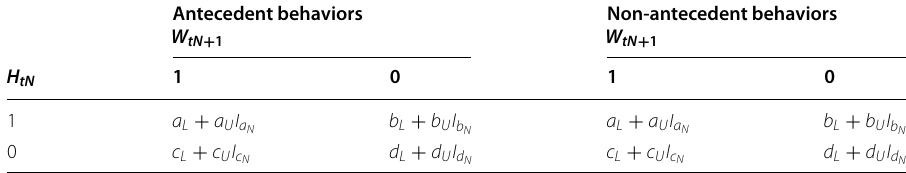
Table 1 The neutrosophic 2 × 2 contingency table Antecedent behaviors W tN +